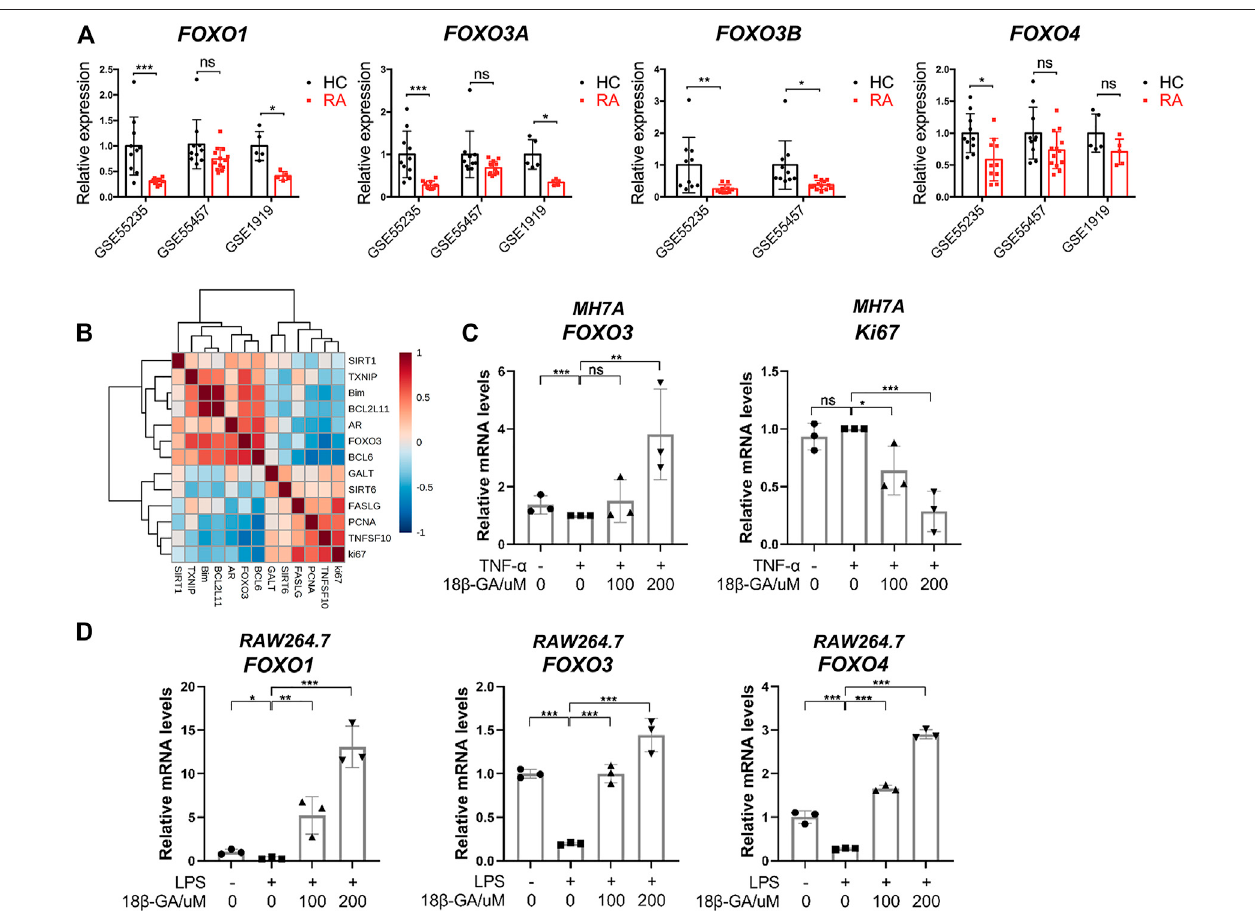
FIGURE 3 | The dysregulation of the FOXO family in the synovial tissue of RA and the effects of 18 β -GA on the FOXO pathway. (A) The relative expression of FOXO1, FOXO3a, FOXO3b, and FOXO4 in the synovial tissue of healthy people (HC) and rheumatoid arthritis patients (RA). Data are extracted from online microarray datasets,includingGSE55235( n (cid:2) 10forHCandRA),GSE55457( n (cid:2) 10forHCandRA),andGSE1919( n (cid:2) 5forHCandRA).Dataareshownasmean ± SD.nsmeans no signi fi cant change; * p < 0.05; *** p < 0.001. (B) Correlation heatmap of indicated genes in the synovial tissue of joint from RA patients (GSE55235). (C) Relative mRNA levels of FOXO3 and Ki67 were detected by RT-qPCR in MH7A cells. Data are shown as mean ± SD. ns, *, ** , and *** mean no signi fi cant change, p < 0.05, p < 0.01, and p < 0.001, n (cid:2) 3. (D) Relative mRNAlevelsofFOXO1,FOXO3,andFOXO4 weredetected byRT-qPCRinRAW264.7cells.Dataareshownasmean ± SD.ns, *, ** , and *** mean no signi fi cant change, p < 0.05, p < 0.01, and p < 0.001, n (cid:2)